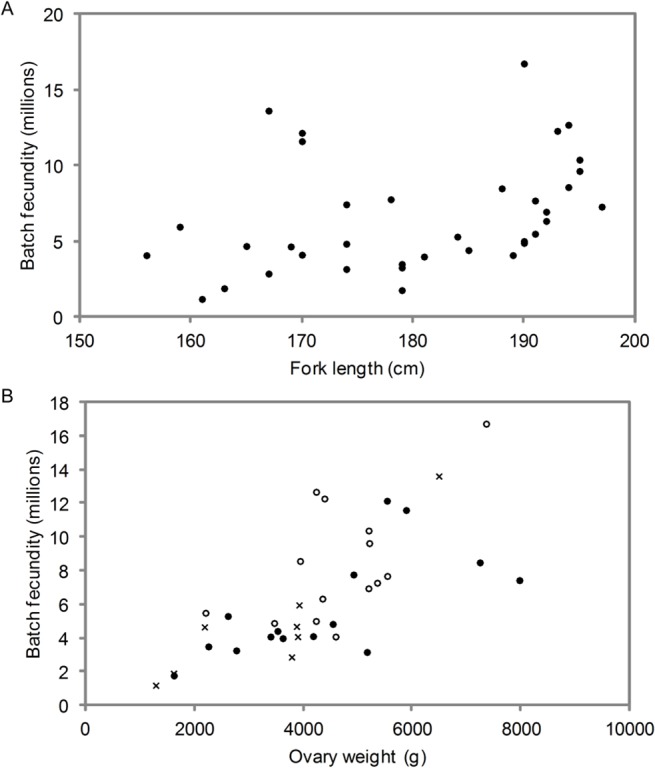
Relationship between batch fecundity and fork length (A) and ovary weight (B) (n = 36).Data for (B) are separated into three fork length classes; x = <170 cm, ● = 170–189 cm, ○ = ≥190 cm FL.